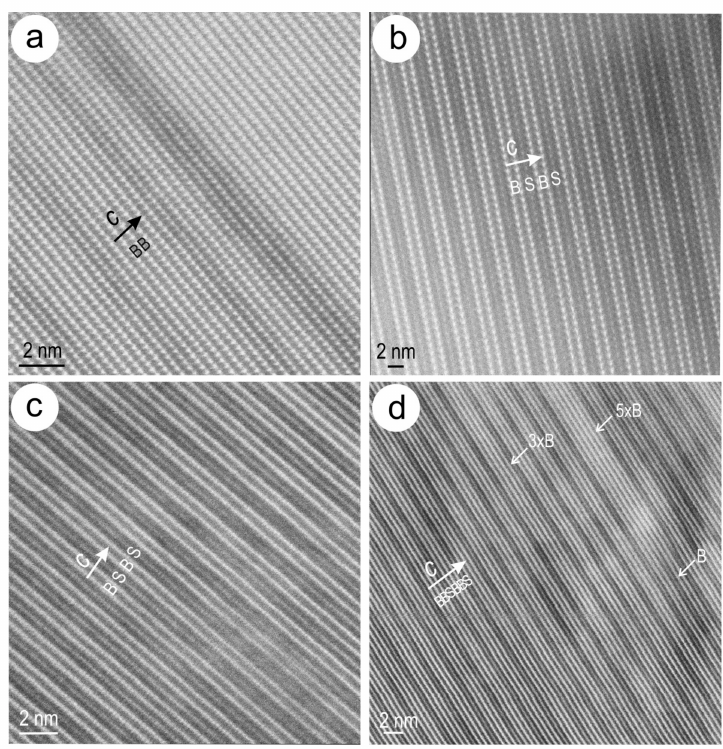
Figure 8. HHADF STEM images showing the typical stacking sequences in the three BSG compounds identified. ( a ) Bastnäsite down to [ − 1100] showing the arrays of bright atoms interpreted as Ln (‘d’ layers). The B slab is represented by two rows of bright atoms. Darkening of layers represents most likely an artefact of the foil thickness/uneven orientation; ( b , c ) Parisite down to [ − 1100] and [10 − 10] zone axis, respectively. The sequence is characterised by two rows of bright atoms (B slab) and one row of slightly darker atoms (‘f’ layer in the middle of the S slab); ( d ) B 2 S imaged down to [10 − 10] zone axis. Note the density of atoms (at ~2 Å distance) along b axis in ( c , d ); The sequence is represented by three rows of bright atoms (2B slabs) and one row of slightly darker atoms (S slab). Defects as B slabs of variable width are arrowed in ( d